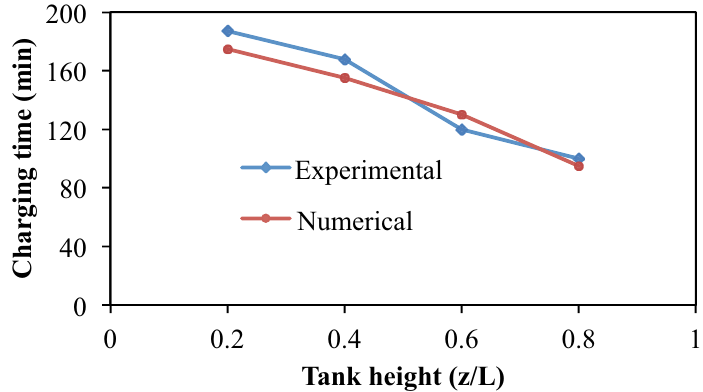
Fig. 3. Charging time of the tank at different height of the bed for various fl ow